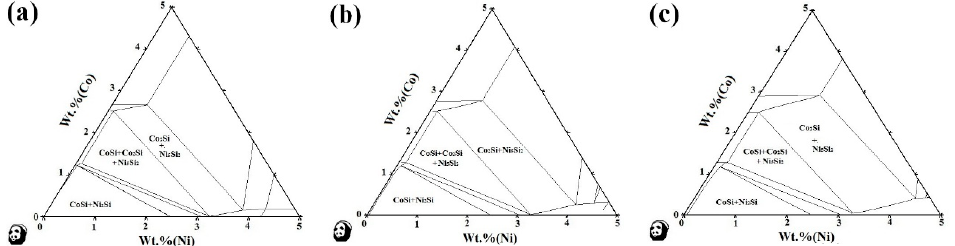
Figure 2. The equilibrium phase of the Co-Ni-Co-Si alloy with Ni, Co contents ( a ) 400 °C. ( b ) 450 °C. ( c ) 500 °C.